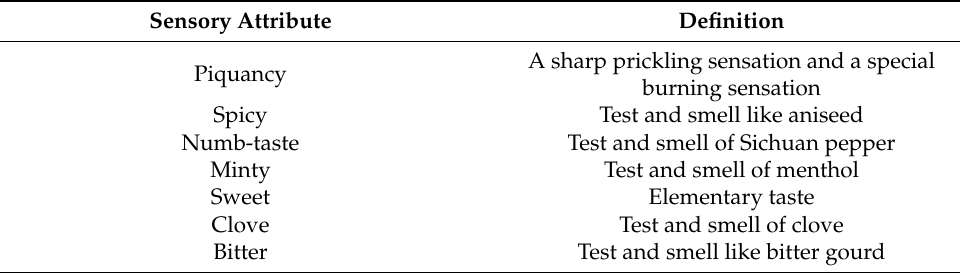
Table 1. Definitions of sensory attributes for